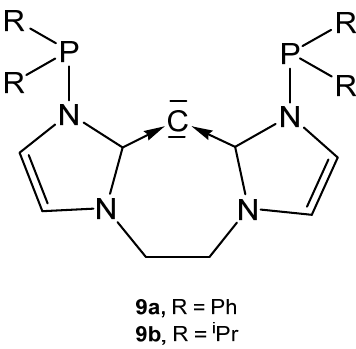
Figure 12. Hypothetical free carbones 9a and 9b .